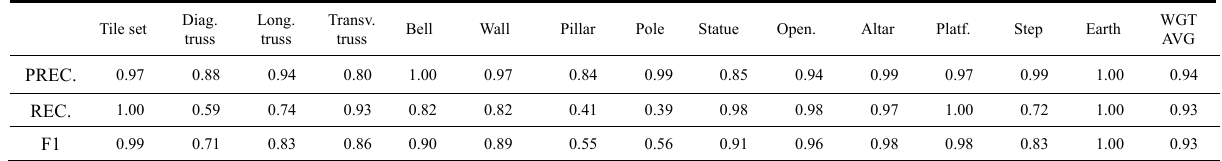
Table 5. RF non-hierarchical classification metrics for